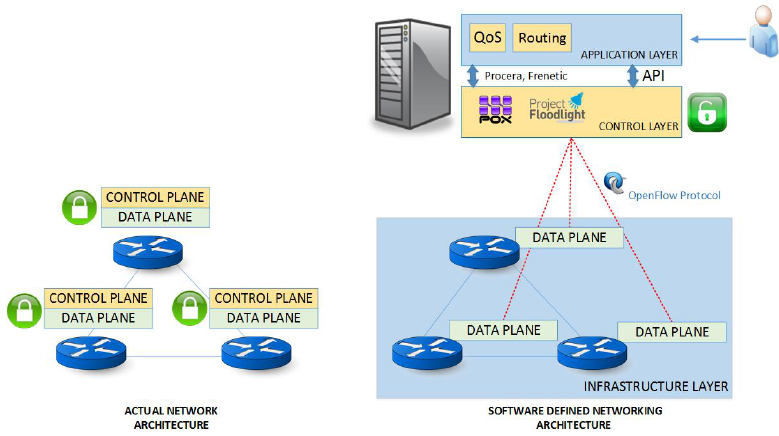
Figure 1. SDN vs. Traditional